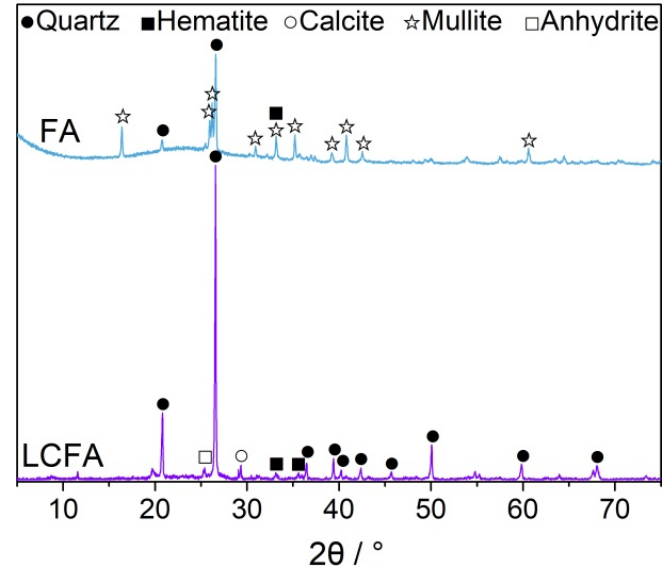
Figure 2. Mineral composition of LCFA and FA.